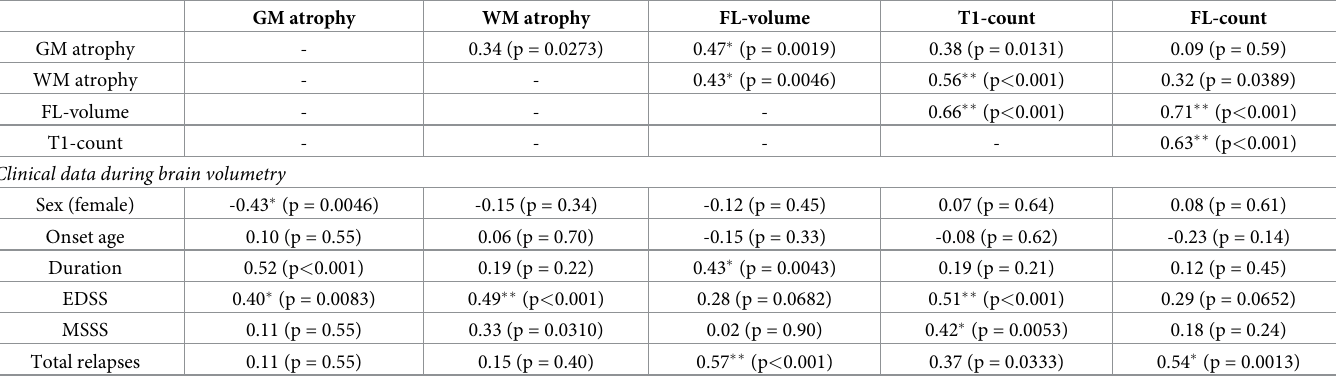
Table 1. A correlation matrix with volumetric data in the enrolled 42 patients.